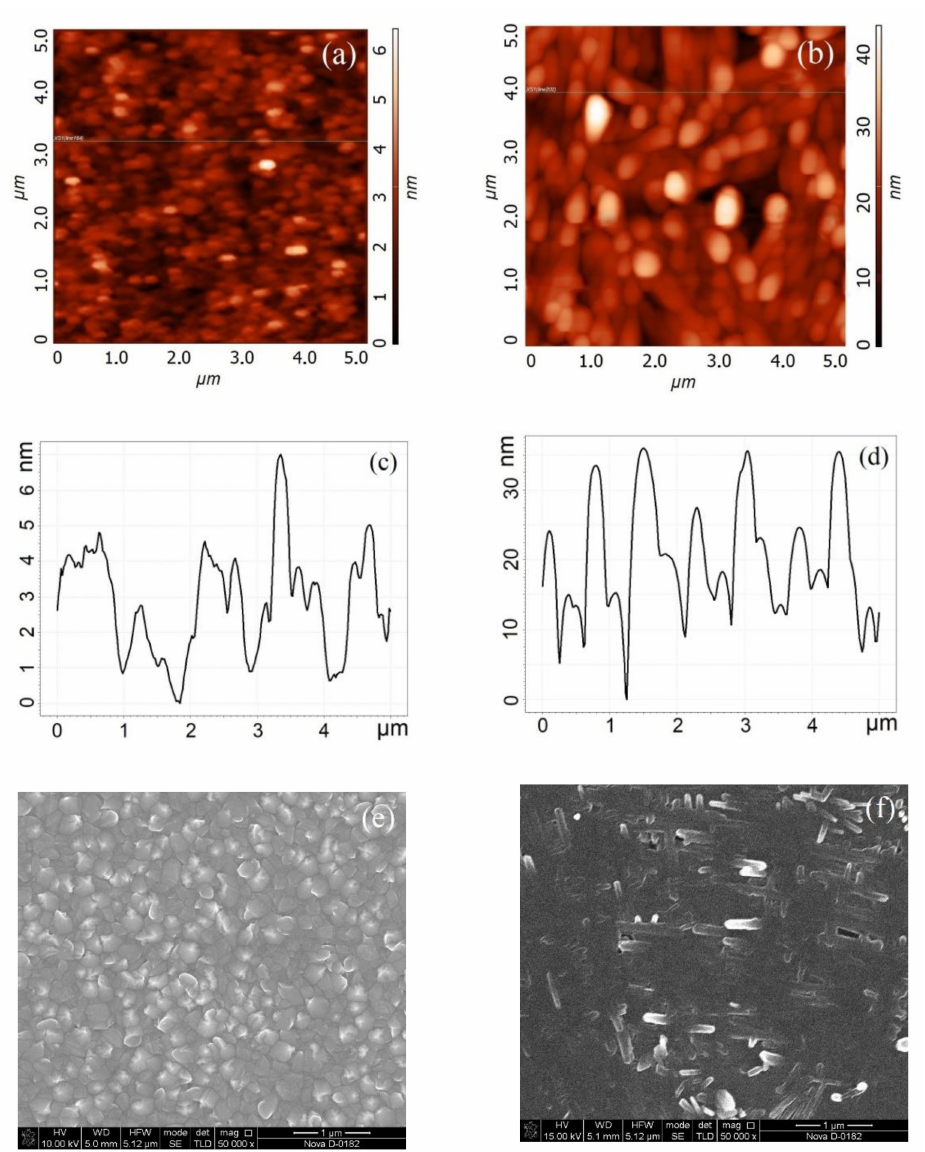
Figure 1. Vanadium oxide film surface formed at 10,000 pulse number ( a , c , e ) and at 60,000 pulse number ( b , d , f ): ( a , b )—AFM-images; ( c , d )—AFM cross-section; ( e , f